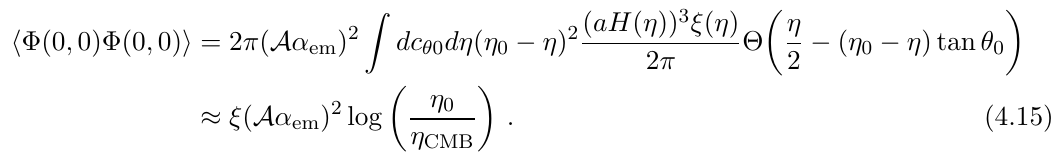
Figure 3 . The two-point function of polarization rotation angle (normalized by (cid:24) A 2 (cid:11) 2 black solid line is the analytical estimate calculated in the text with loops with a random normal direction compared to that of the photon trajectory. The blue solid, yellow dashed and the red dotted lines and the corresponding shaded regions show the central value and standard deviation of the two point functions from the toy simulation for (cid:24) = 1 ; 10 ; 100, respectively. The uncertainties are mainly due to cosmic